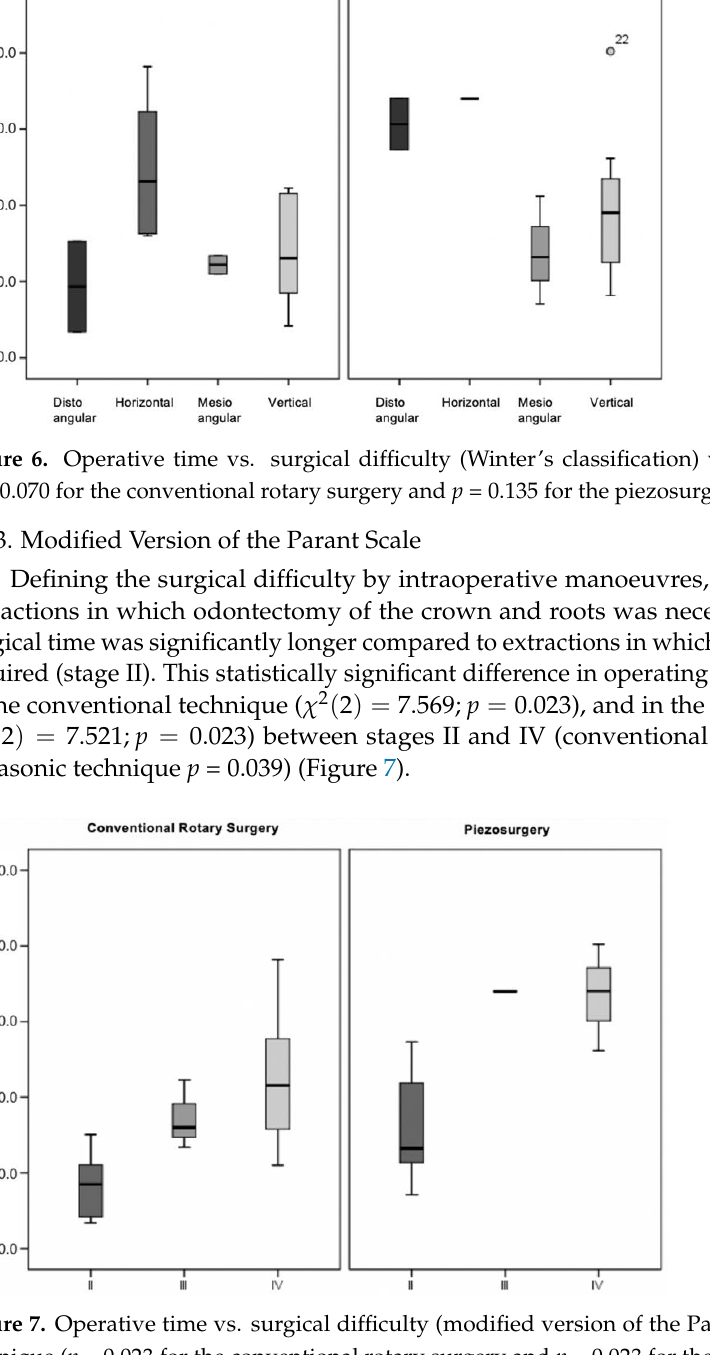
Figure 8. Operative time vs. surgical technique ( p = 0.271 for the comparison between the two tech- niques). 3.5. Postoperative Pain 3.5.1. Pain vs. Surgical Technique (VAS) The pain was evaluated daily by the patient. Analysing the mean values (± standard deviation) of pain for the two operative techniques, the same values were found in six of the eight days. Different pain levels were registered on the first postoperative day, in which conventional surgery had higher values and on the seventh postoperative day, in which ultrasound surgery showed higher values. The differences between the control and test groups were not statistically significant ( 𝐹(7; 196) = 0.334; 𝑝 = 0.938 ) (Table 1).